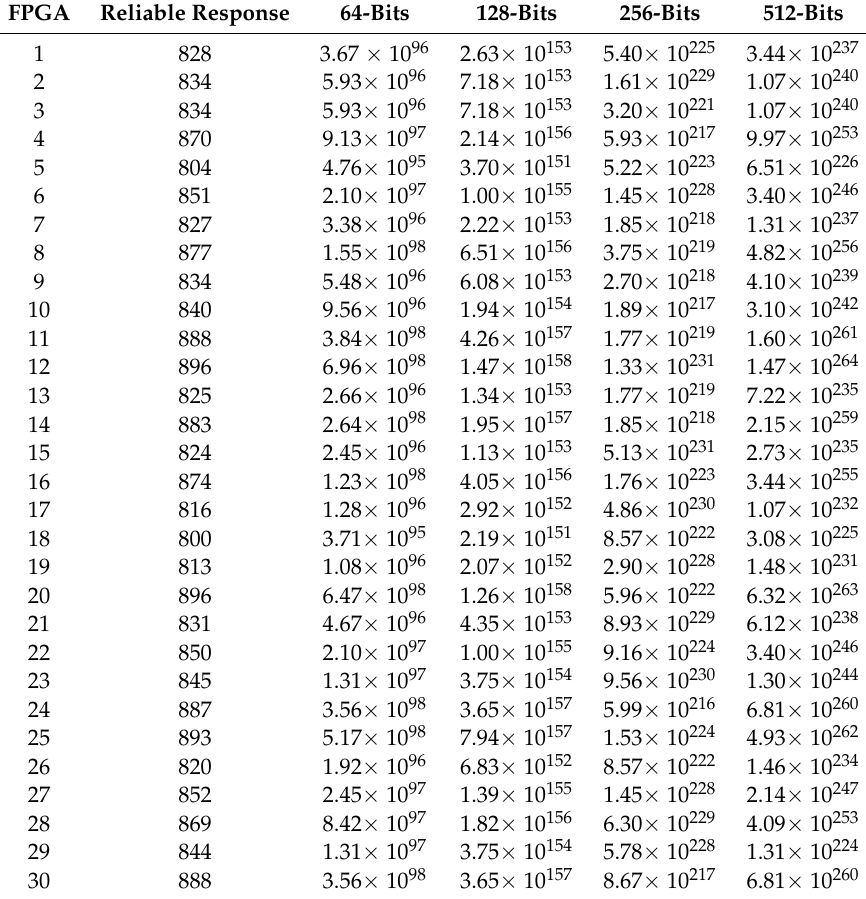
Table 1. Reliable d-ROPUF response bits generated at varying